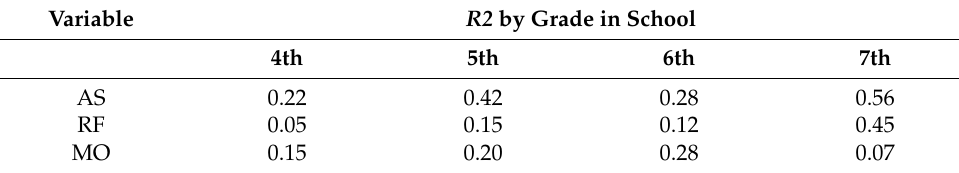
Table 3. Effect size: Variance accounted for ( R 2) by variable and grade in